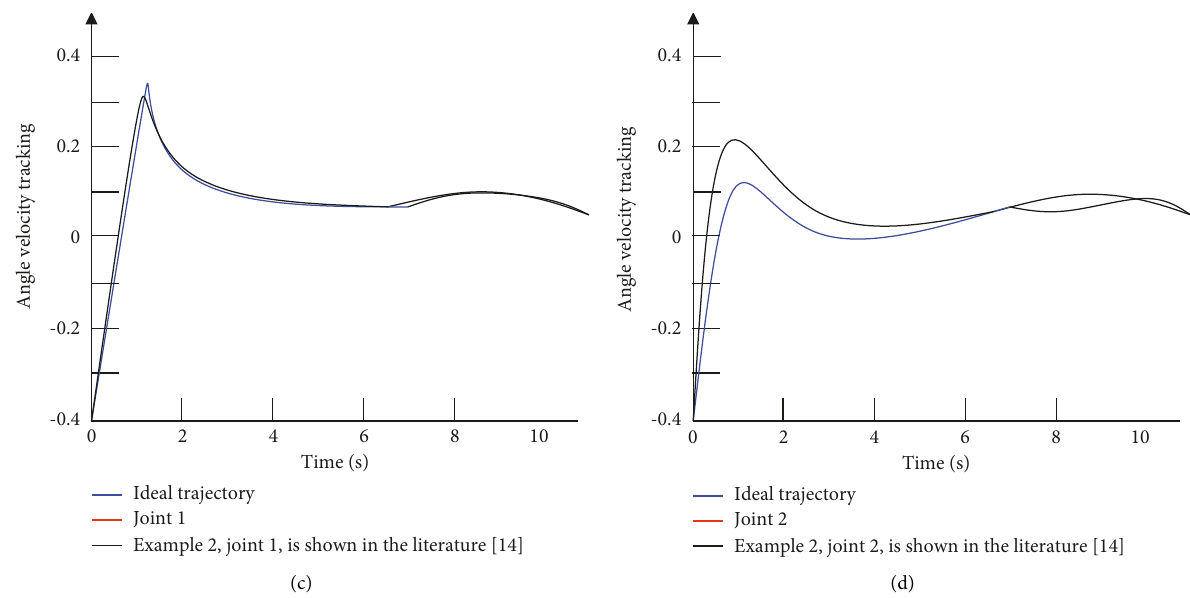
Figure 8: Simulation curve of the control input of the joint manipulator. (a) Joint 1 angle tracking, (b) Joint 2 angle tracking, (c) Joint 1- angular velocity tracking, (d) Joint 2-angular velocity